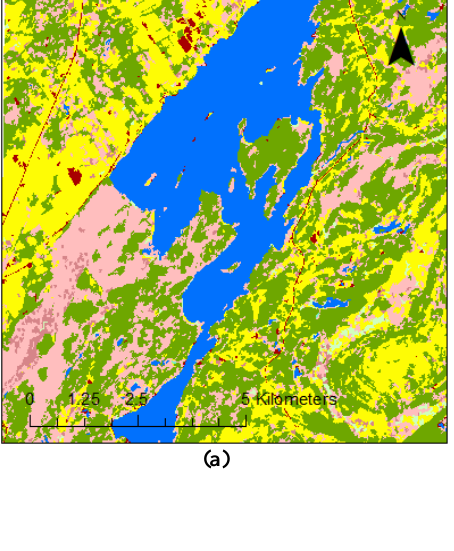
Figure 2. (a) The Sentinel-2 imagery of the study site was acquired in summer 2021. (b) The zoom-in segmentation is superimposed on the classified map. c and d) Sentinel-1 imagery of the area. e and f) Alos-Palsar imagery of the area.